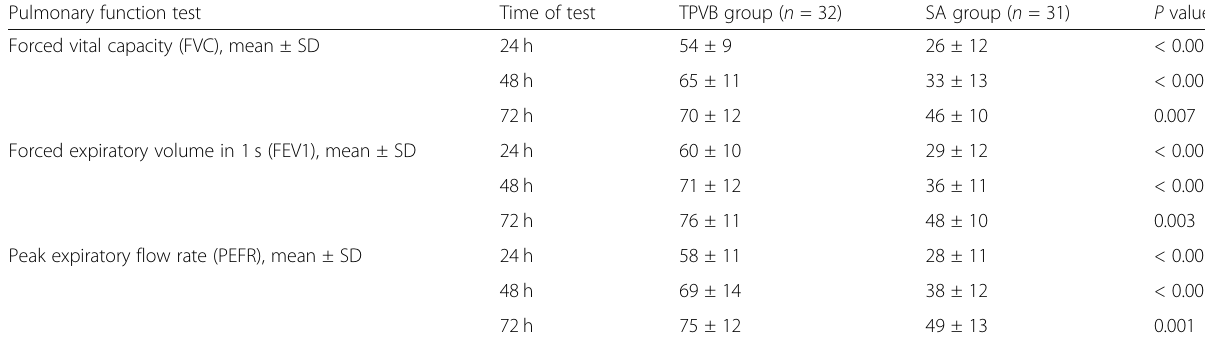
Table 5 Postoperative changes in pulmonary function tests (expressed as a percent of preoperative values) Pulmonary function test Time of